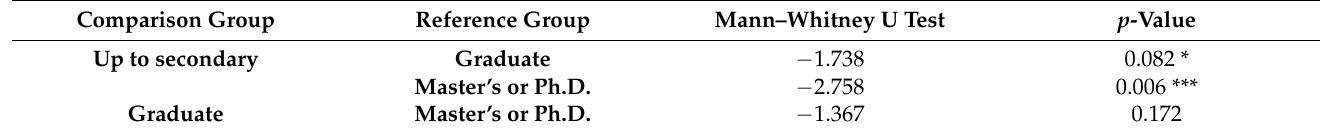
Table 5. Results of the multiple comparisons to the different groups of consumers.